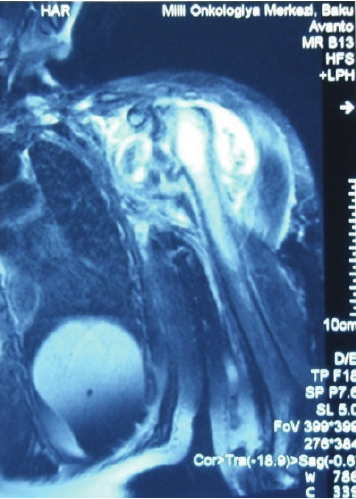
Figure 3: Axial MRI of the left shoulder revealed destruction of the humeral head, synovial hypertrophy, a large amount of joint effusion, and an irregular mass